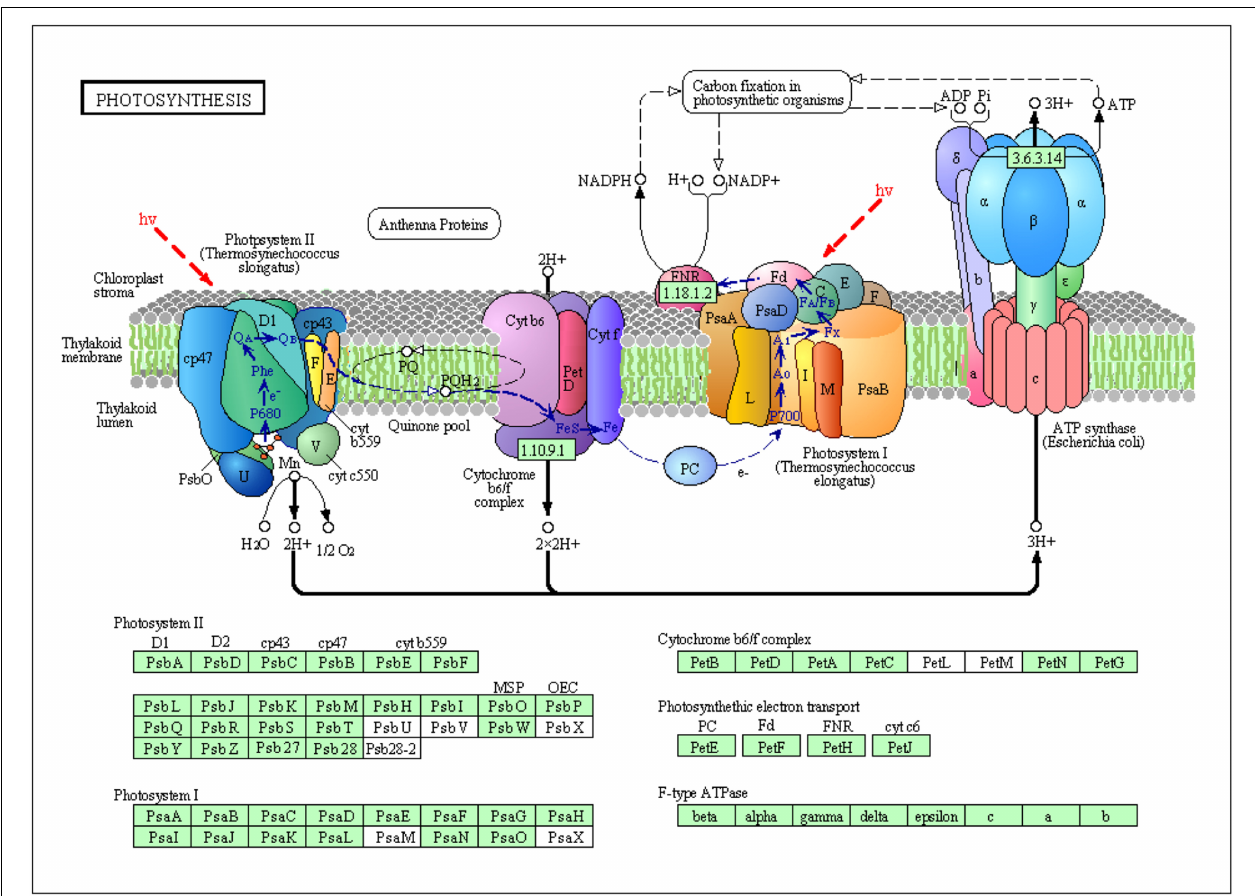
FIGURE 8 | Schematic presentation of salinity stress-responsive proteins involved in photosystem and electron transport in T. Nitraria